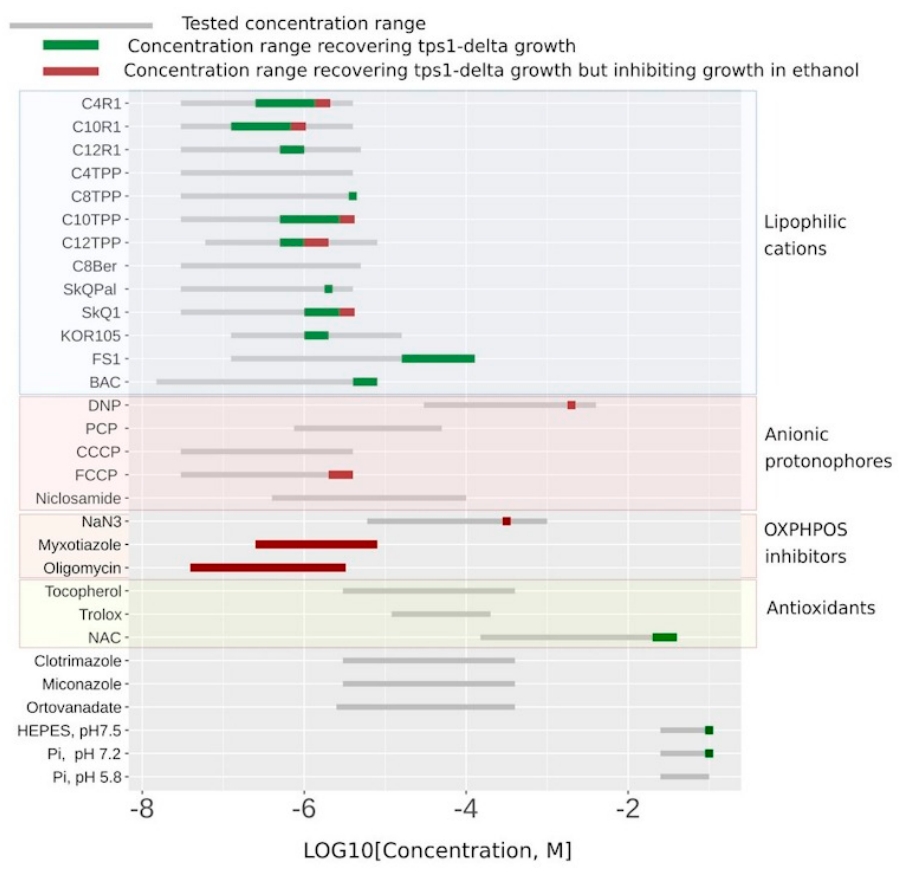
Figure 4. A list of chemicals tested for their ability to stimulate the growth of tps1-delta cells in the presence of glucose. The concentrations that did not produce any stimulation are shown in gray. The concentrations that correspond to the flat-followed-by-steep-shaped growth curves are shown in green; steep-followed-by-flat-shaped, in red.